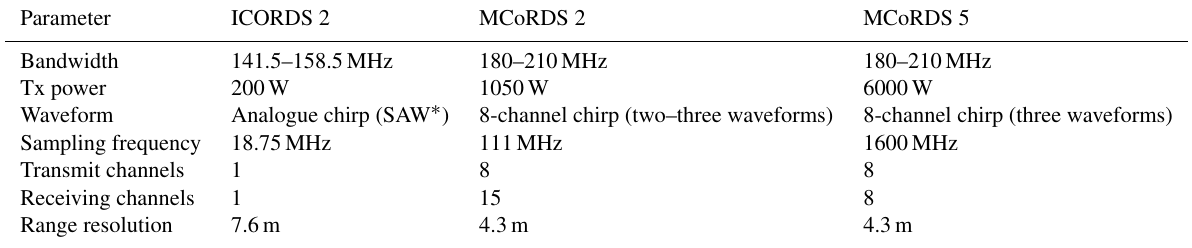
Table 2. Operating parameters of the radar systems used for data acquisition. Further details can be found in Gogineni et al. (2001), Byers et al. (2012) and Franke et al. (2021b).